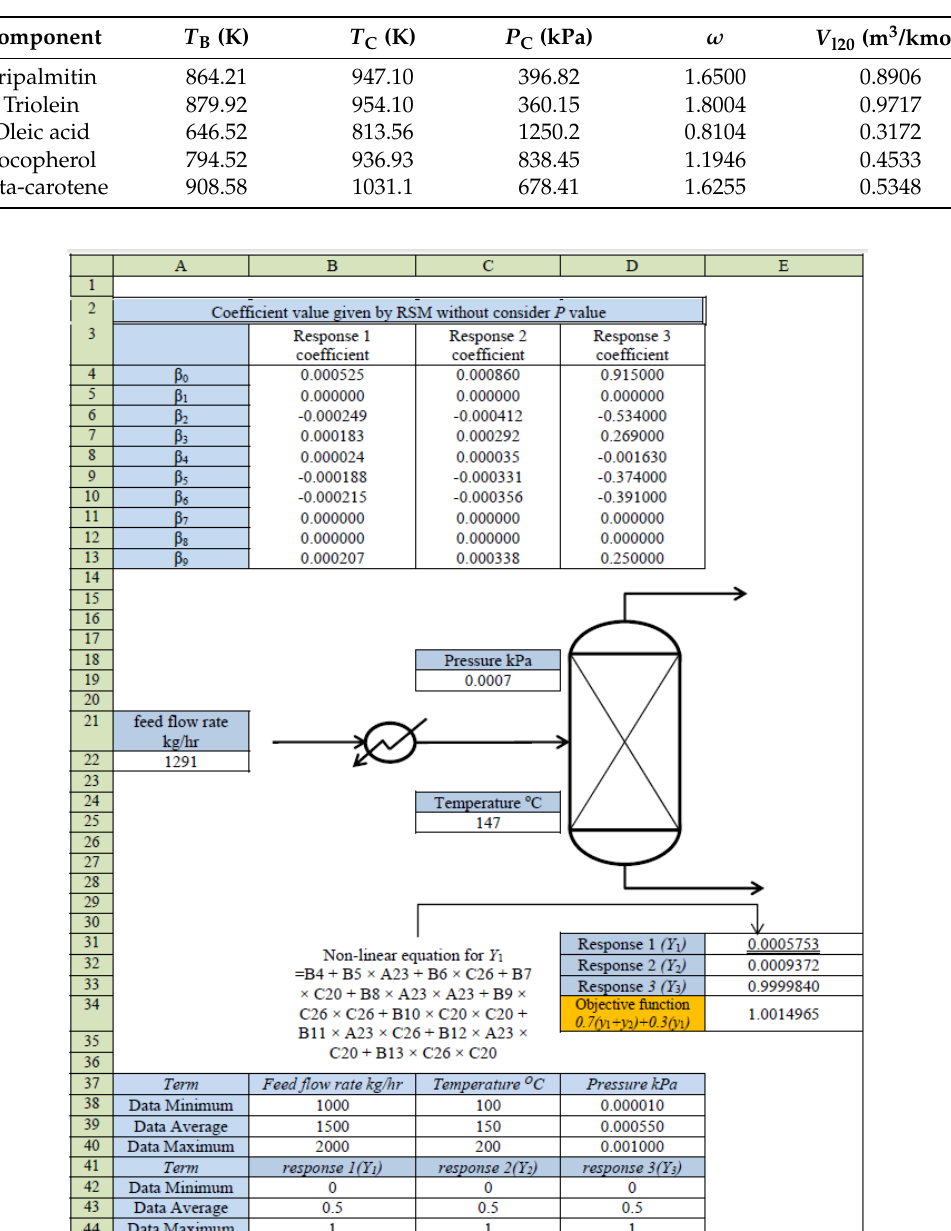
Figure A1. The solver Excel spread sheet.